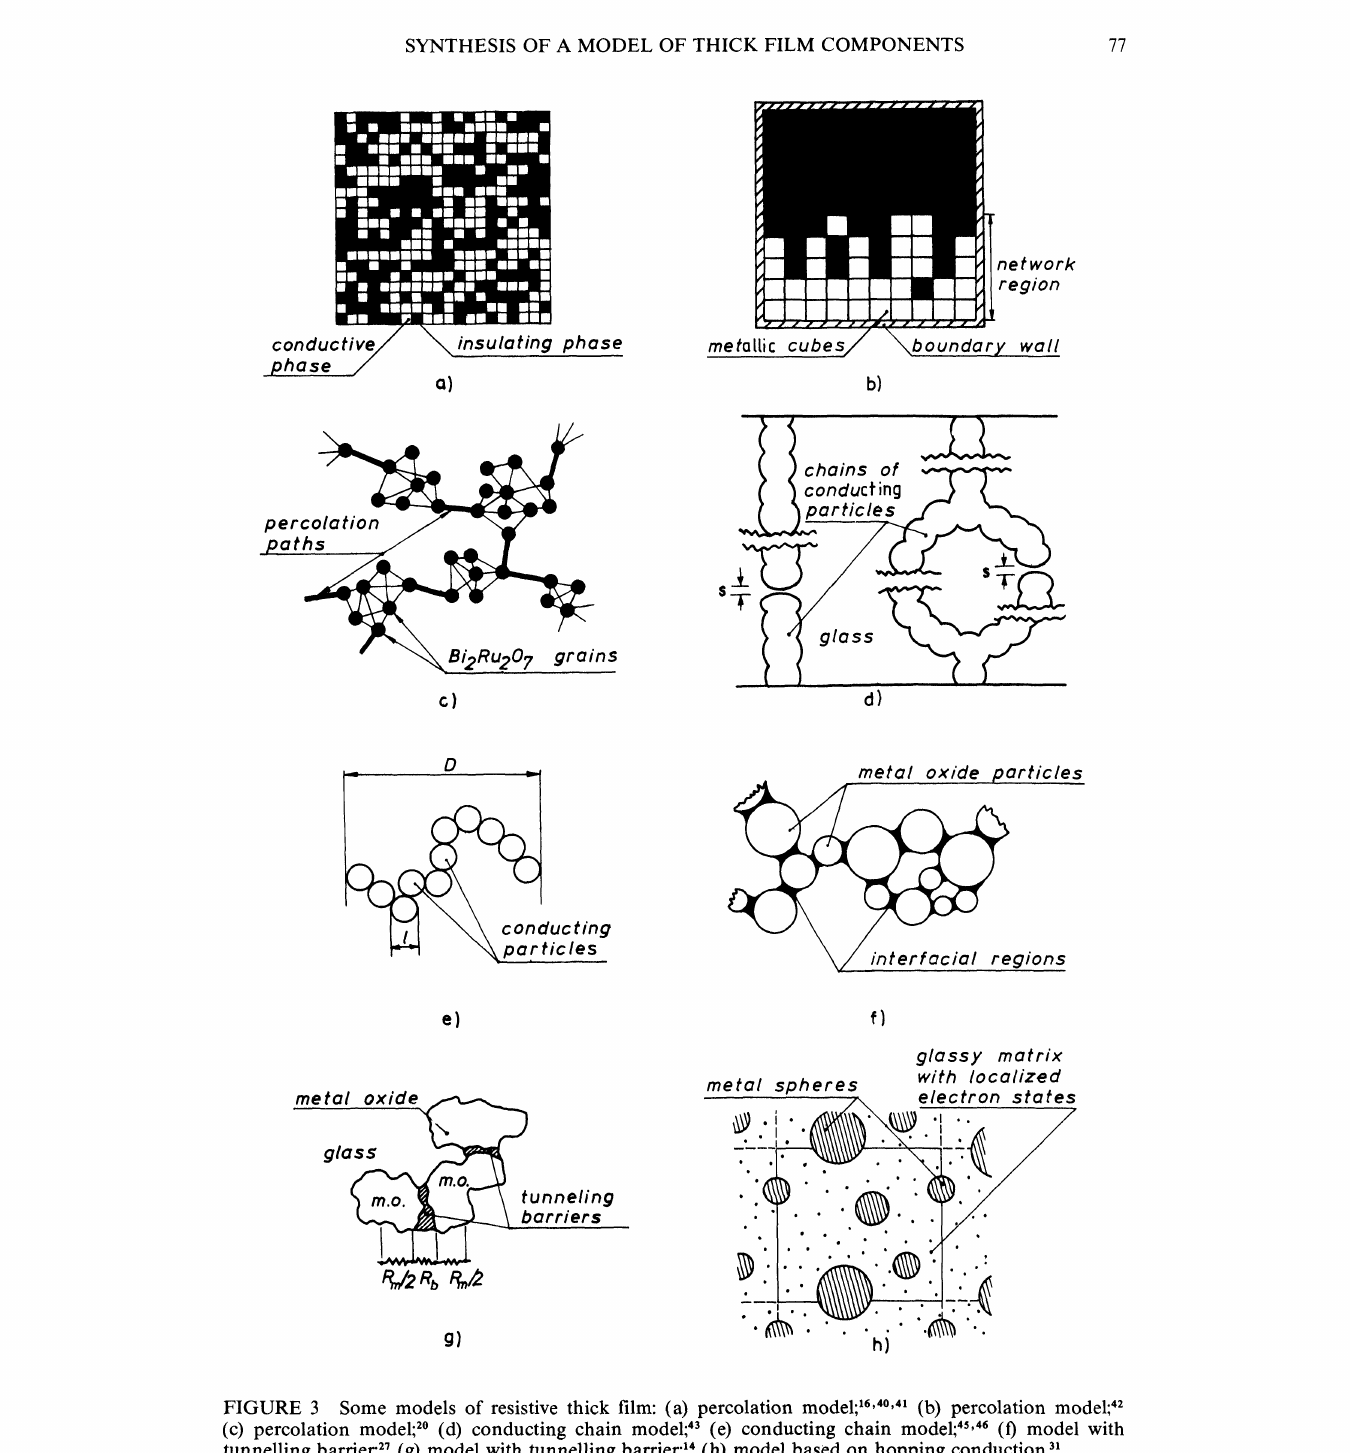
FIGURE 3 Some models of resistive thick film: (a) percolation model; 1,4,4 (b) percolation model; (c) percolation model; (d) conducting chain model; (e) conducting chain model; tunnelling barrier, (g) model with tunnelling barrier; (h) model based on hopping